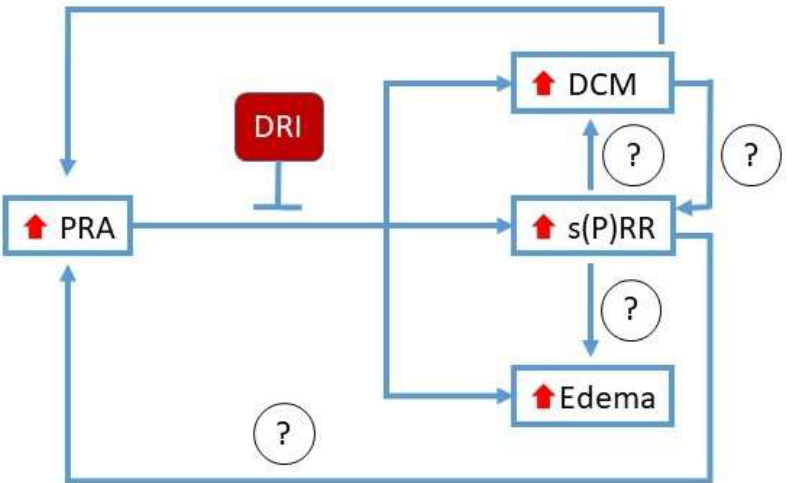
Figure 5. Simplified schematic summary. Levels of PRA, s(P)RR, and edema increase in worsening dilated cardiomyopathy (DCM) with HF without renal impairment. Levels of PRA and s(P)RR are closely correlated. Increased PRA activates the RAAS to enhance edema formation and worsen DCM. Normalization of PRA level with a direct renin inhibitor (DRI) suppresses s(P)RR, edema, and progression of cardiomyopathy to HFrEF. Increased levels of s(P)RR may worsen DCM and promote edema through direct effects or through indirect effects, by increasing PRA. In HFrEF without chronic kidney disease, the protective effects of DRI may be mediated in part through suppression of